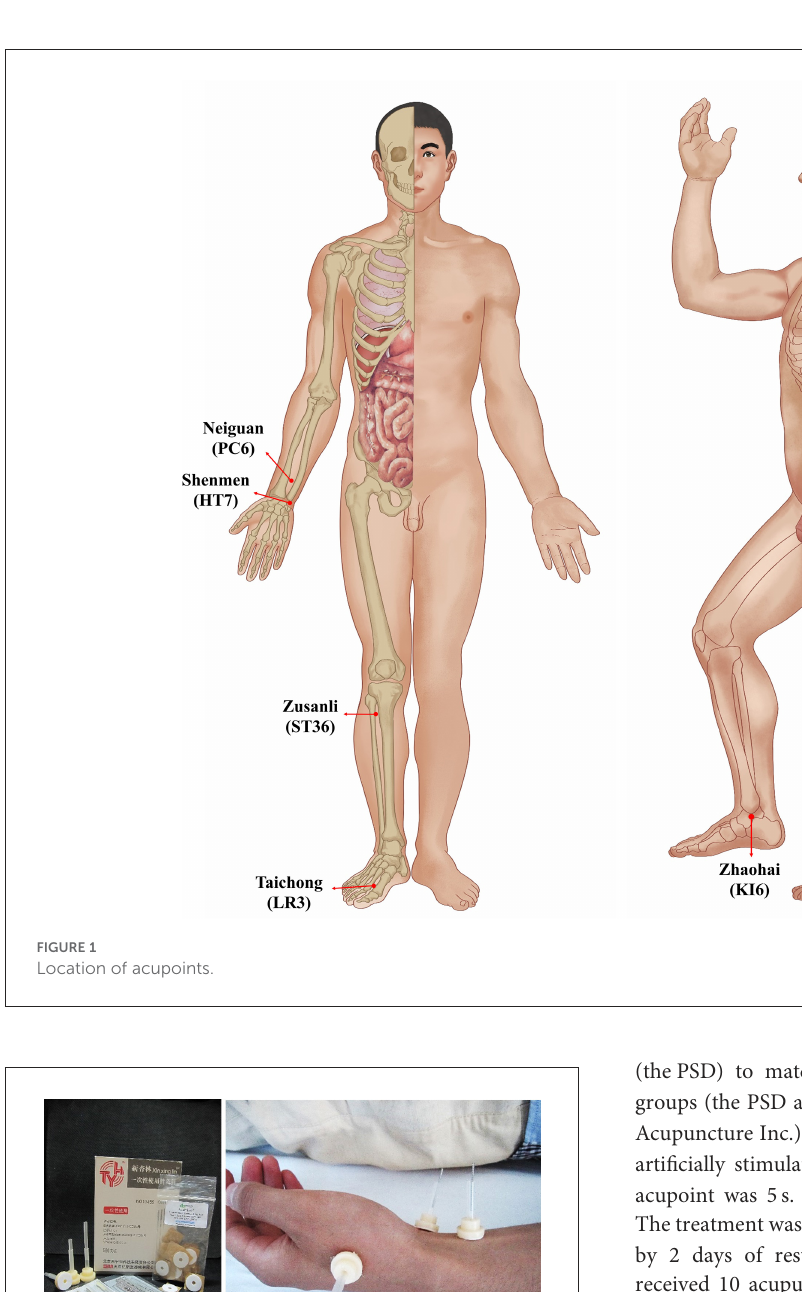
FIGURE2 The active or sham acupuncture intervention (PSD, real an d blunt needles).